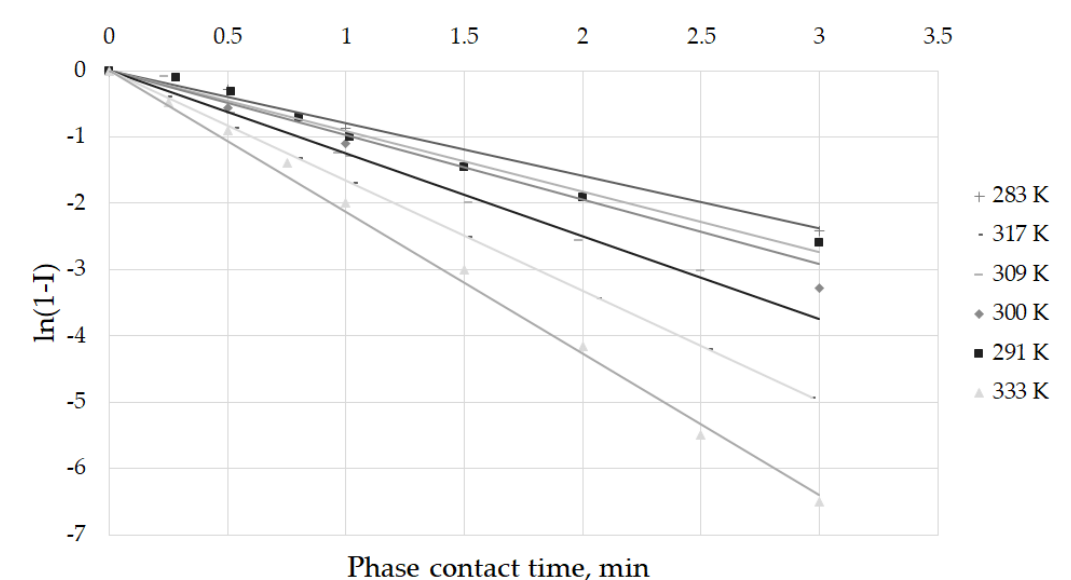
Figure 4. The logarithmic dependences of the degree of approaching to equilibrium on the temperature at a stirring rate of 400 RPM.